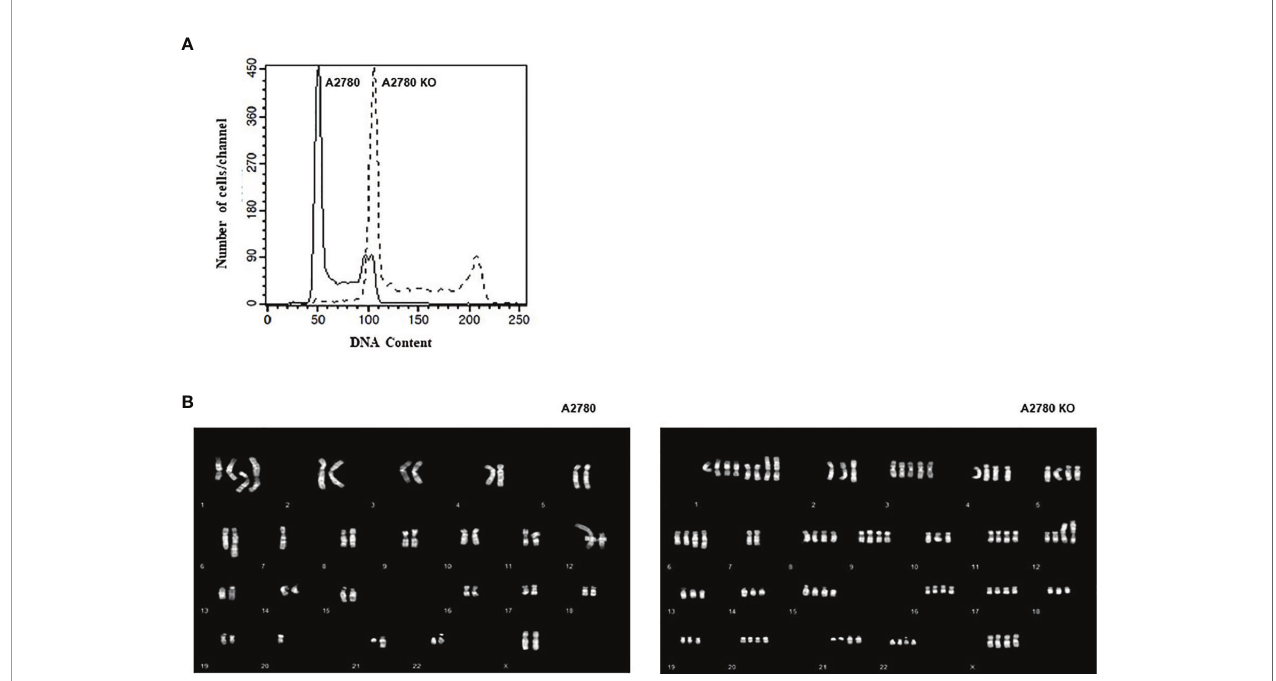
FIGURE 3 | (A) Flow cytometric analysis of DNA content of the cell lines. – : CDK12 WT cell lines, - - : CDK12 KO cell lines. (B) Composite karyotypes of A2780 cell line (left panel) and of A2780 CDK12 KO (right panel).